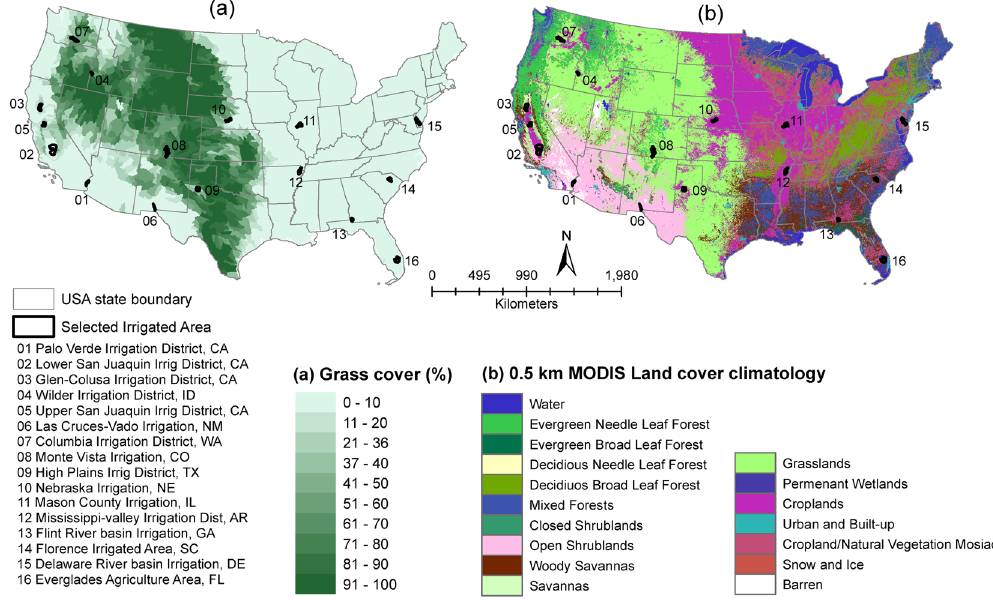
Figure 7. Study area showing ( a ) hydrologic units (HUC-8) dominated by grassland cover and ( b ) map of land cover climatology (0.5 km). Black areas on the map denote the locations of 16 irrigated areas analyzed in this study. The figure was generated using ArcGIS (ArcMap 10.3.1) software